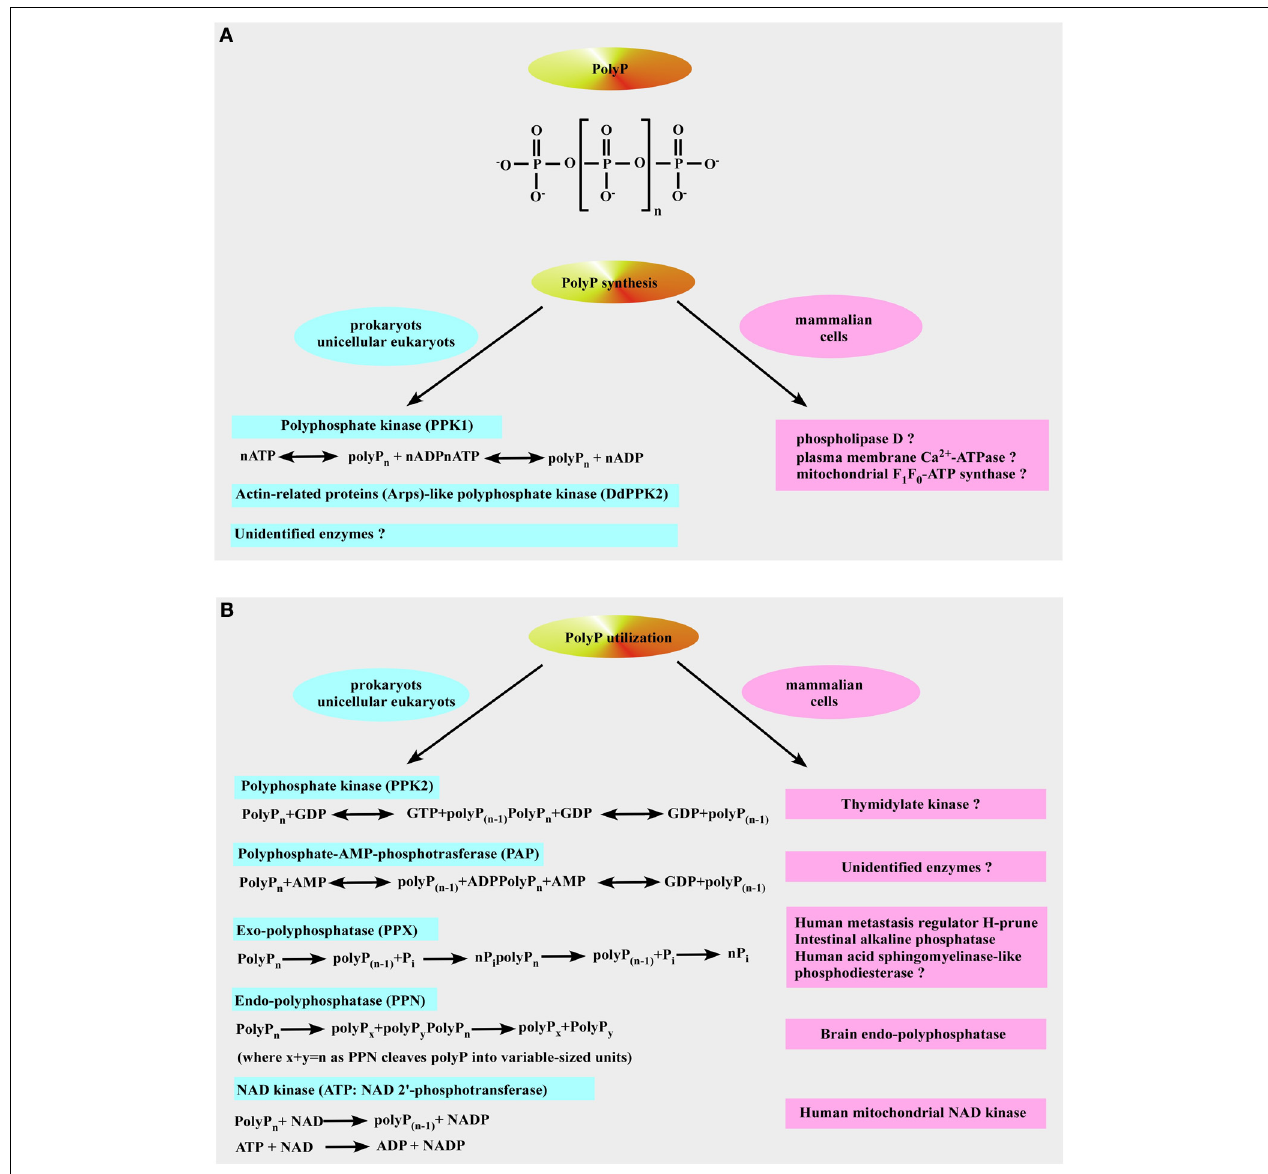
FIGURE 3 | Inorganic polyphosphate structure, formation, and utilization. (A) The upper panel shows the structure of inorganic polyphosphate. The n represents the number of phosphate residues in the polyphosphate chain. It could vary from ten to hundreds of units. The bottom panel is a schematic representation of polyP formation by polyP-generating